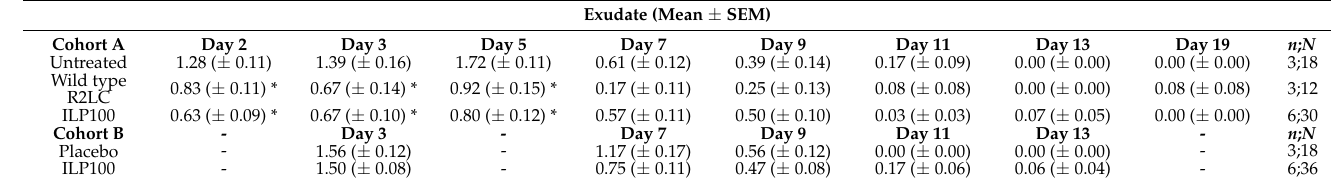
Table A4. Average score (0–4) for exudate for untreated wounds, wounds treated with wild type L. reuteri R2LC or ILP100 in Cohort A and wounds treated with placebo or ILP100 wounds in Cohort B. For time points not included in the table, all wounds in all groups were scored as 0. * p < 0.05.